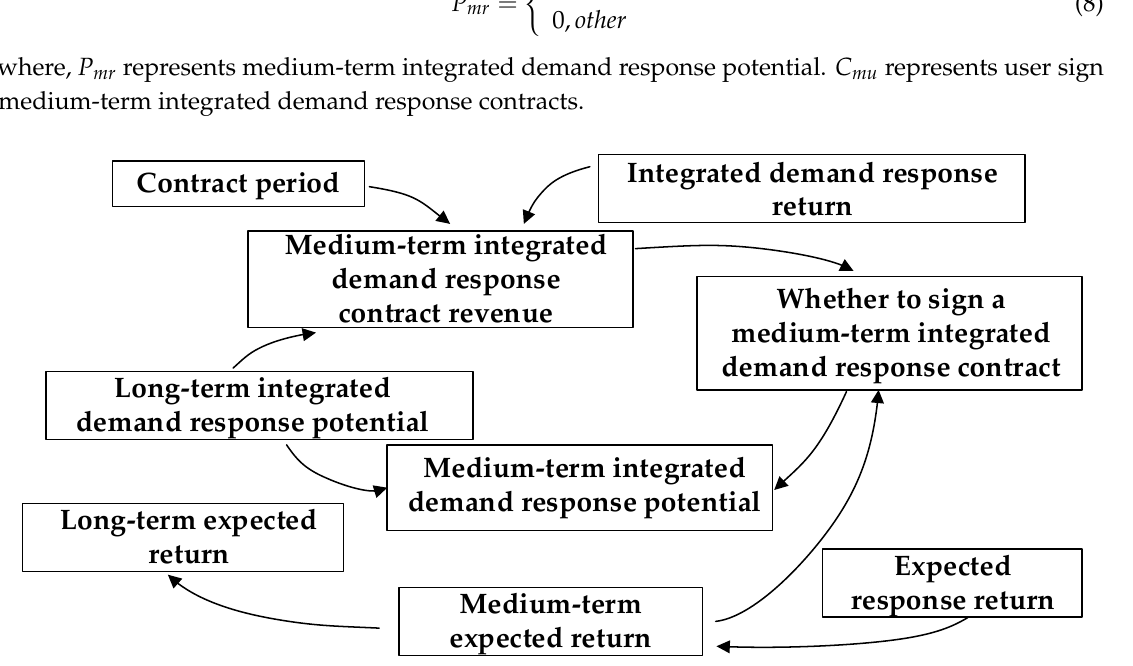
Figure 4. Medium-term integrated demand response decision module stock flow chart.